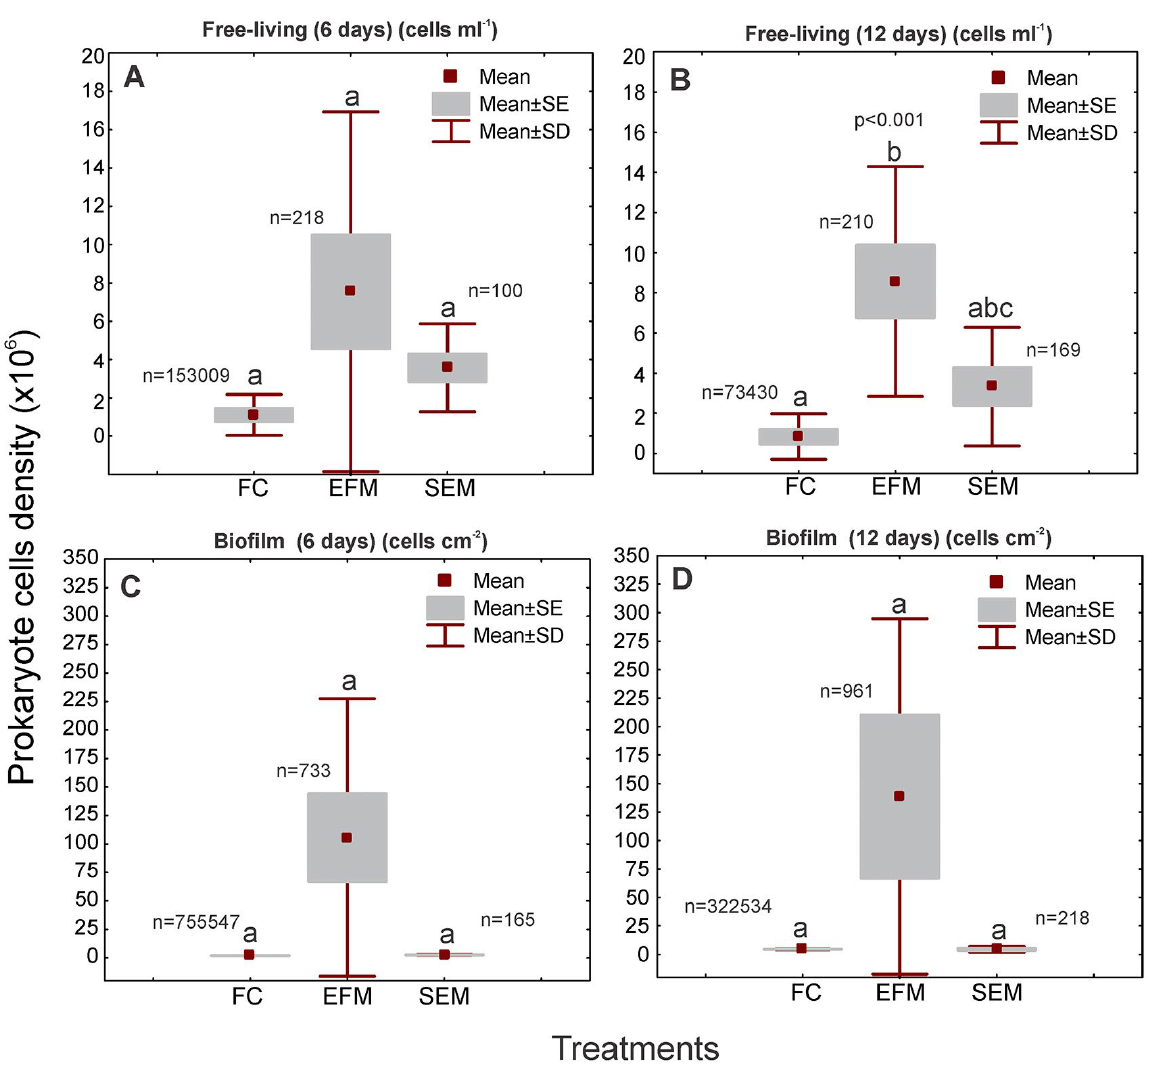
Fig. 3. – GLM results showing differences in free-living (cells ml –1 ) and biofilm (cells cm –2 ) prokaryote density between flow cytometer (FC- unstained), epifluorescence microscopy (EFM-AO stain) and scanning electron microscopy (SEM). A, free-living prokaryotes at 6 days; B, free-living prokaryotes at 12 days; C, biofilm prokaryotes at 6 days; D, biofilm prokaryotes at 12 days. Lowercase letters indicate statistical similarities (p>0.05) or differences